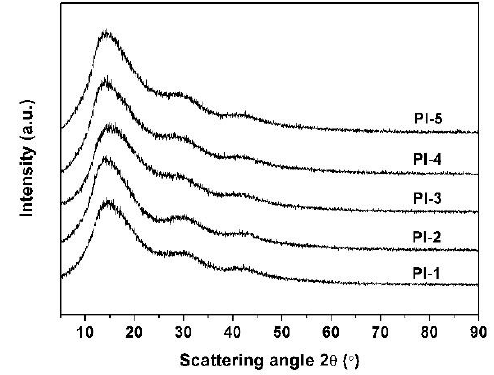
Figure 3. X-ray di ff raction (XRD) spectra of PI coatings. Figure 3. X-ray diffraction ( XRD) spectra of PI coatings.